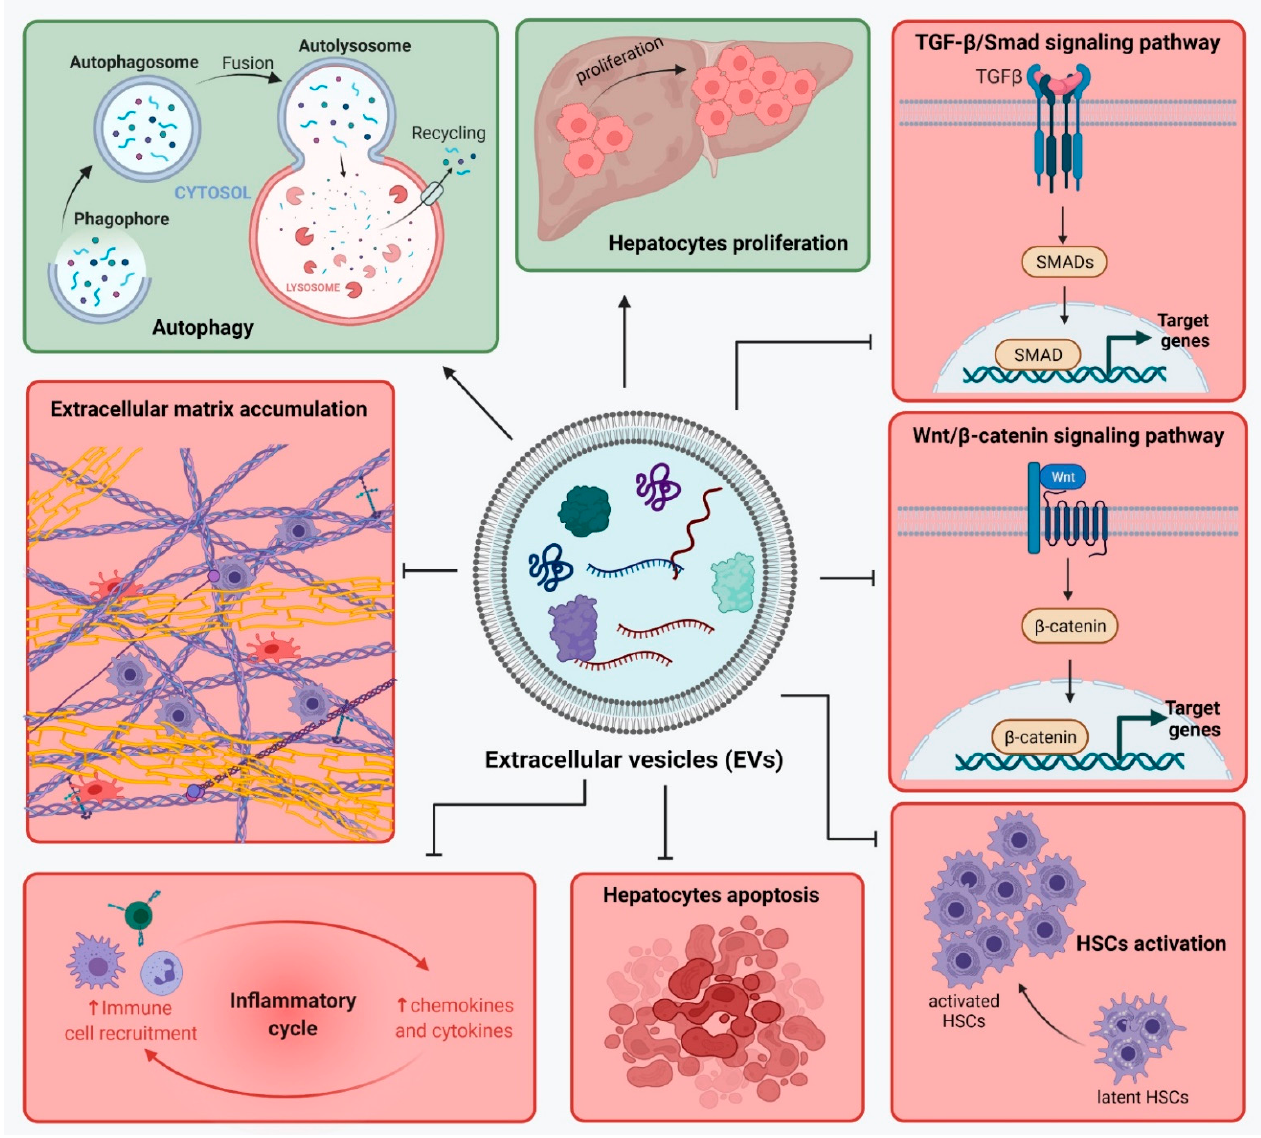
Figure 2. Extracellular vesicles from mesenchymal stem cells ( MSC-EVs) modulate liver regeneration by regulating pathways involved in liver fibrosis development. EVs’ content is rich in proteins, lipids, mRNA and microRNA. MSC-EVs may act in two distinct ways: Green —Inhibition of: TGF- β 1/Smad signaling pathway, Wnt/ β -catenin pathway, hepatic stellate cells (HSCs) activation, hepatocyte apoptosis, inflammatory factors secretion, collagen deposition; Red —Activation of: autophagy and hepatocyte proliferation. Figure created with BioRender.com on 17 November 2021.